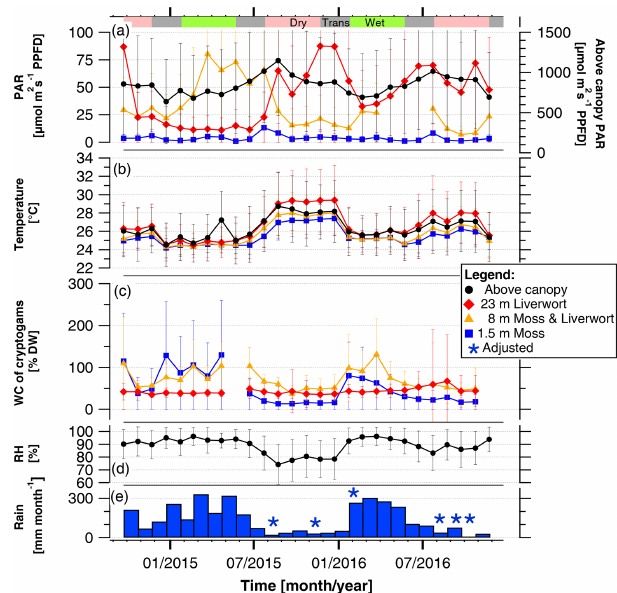
Figure 1. Mean light condition (PAR avg ), temperatures, and water content (WC) experienced by bryophyte communities, and above- canopy meteorological conditions in the Amazonian rain forest. The micrometeorological parameters on top and within epiphytic cryptogamic communities represent monthly mean values ± SD of (a) daily averages (06:00–18:00LT) of photosynthetically active radiation (PAR) on top, (b) temperature within, and (c) WC of cryptogamic communities. The above-canopy meteorological pa- rameters comprise the (a) monthly mean value of the daily aver- age (µmolm − 2 s − 1 PPFD) (06:00–18:00LT) of above-canopy pho- tosynthetically active radiation (PAR at 75m), (b) monthly mean value of above-canopy temperature (at 26m), (d) monthly mean value of relative air humidity (RH at 26m height), and (e) monthly amount of rain. Data of replicate sensors installed within communi- ties at the same height level were pooled, while above-canopy pa- rameters were measured with one sensor each. Colored horizontal bars in the upper part of the figure indicate the seasons. Exact values and additional data are presented in Tables S3 and